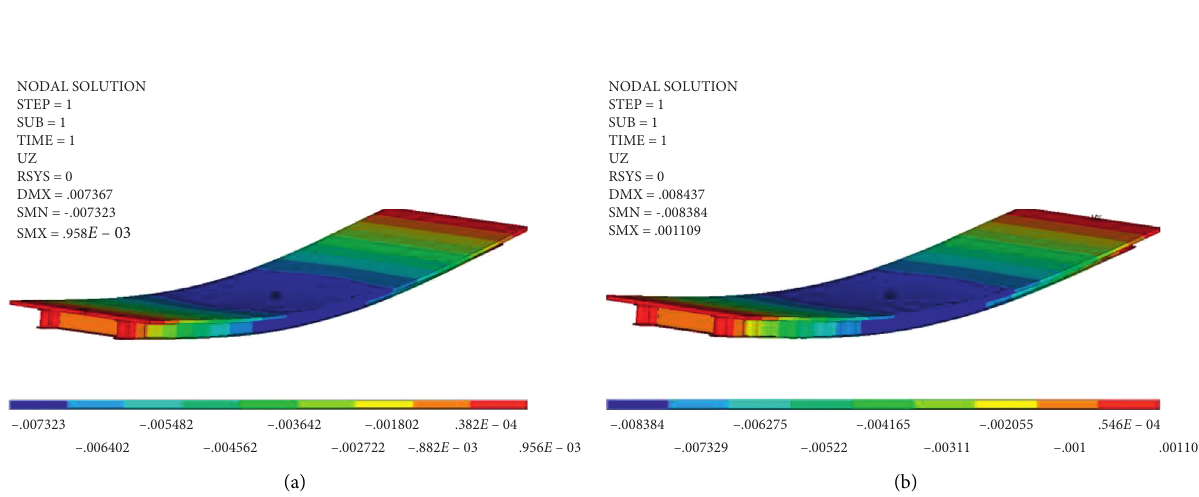
Figure 12: Mid-span deflections: FE model (straight webs) vs. FE model (corrugated webs). (a) FE model with straight webs. (b) FE model with corrugated